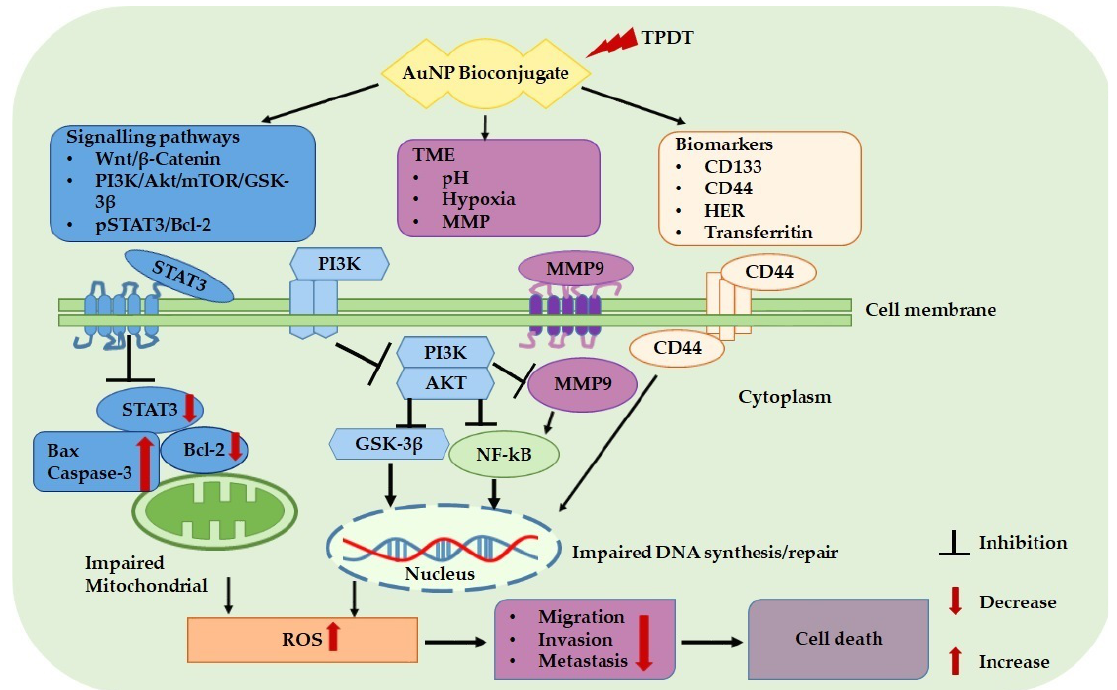
Figure 2. Gold NPs modified with biomolecules that have affinities for cancer/CSCs biomarkers, signaling pathways, and tumor microenvironments with the potential to inhibit invasion, migration, metastasis, and ultimately cell death.